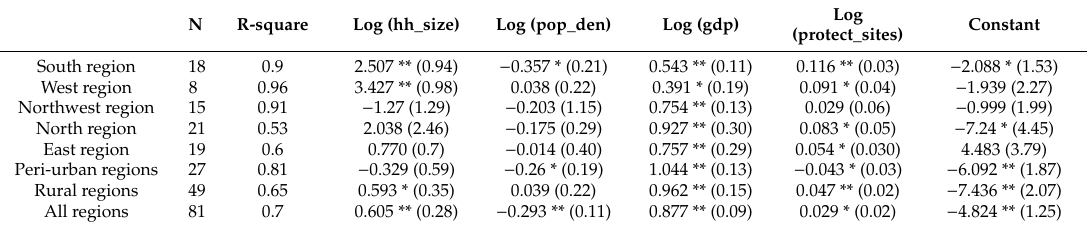
Table 8. Results of the regression analysis explaining development of residential land for di ff erent regions.